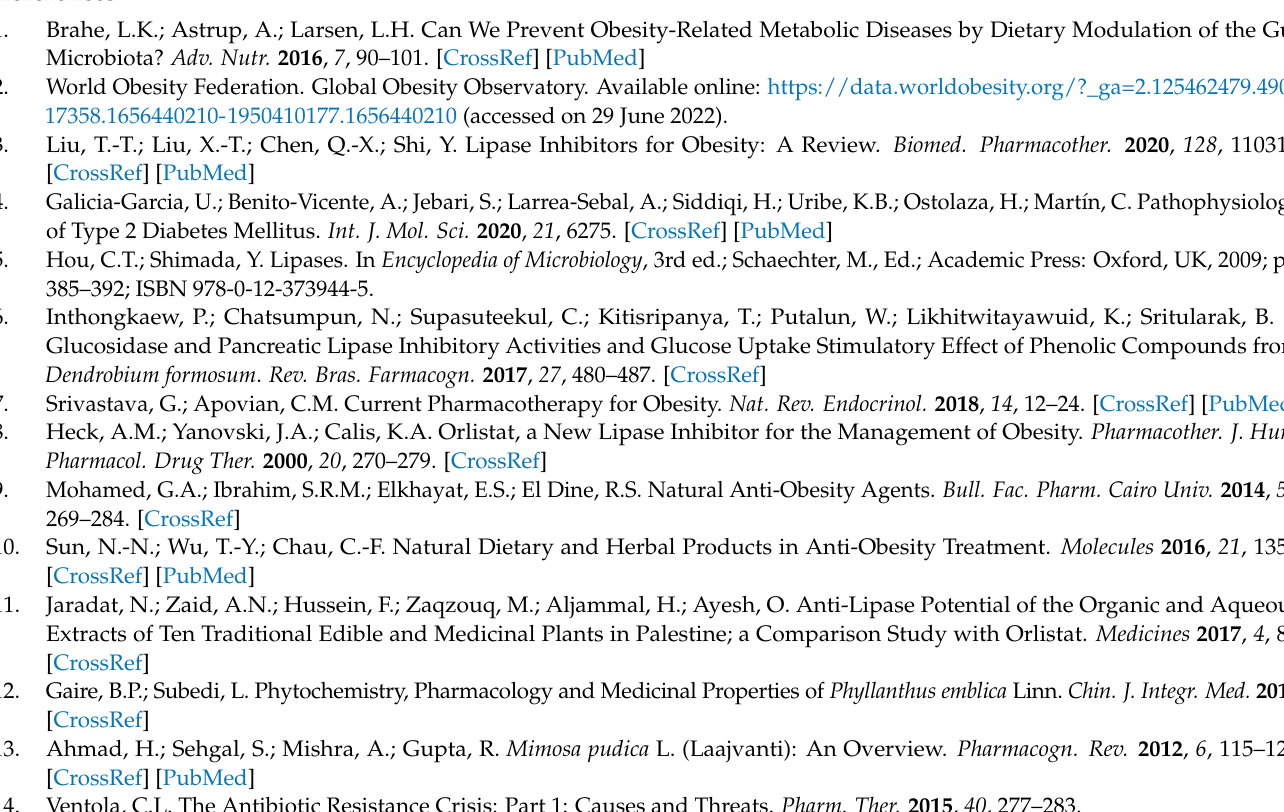
blica against E. coli ; Figure S2: Mass spectrum of Bergenia ciliata ; Figure S3: Mass spectrum of Mimosa pudica ; Figure S4: Mass spectrum of Phyllanthus emblica ; Figure S5: Fragmentation pattern of bergenin; Figure S6: Fragmentation pattern of diosmetin; Figure S7: Fragmentation pattern of trihydroxy-dimethoxyflavone; Figure S8: Fragmentation pattern of catechin/epicatechin; Figure S9: Fragmentation pattern of gallocatechin/epigallocatechin; Figure S10: Fragmentation pattern of chloro- genic acid; Figure S11: Fragmentation pattern of myricetin; Figure S12: Fragmentation pattern of isoquercetin; Figure S13: Fragmentation pattern of prodelphinidin B3; Figure S14: Fragmentation pattern of kaempferol; Figure S15: Fragmentation pattern of emodin; Figure S16: Fragmentation pattern of isorhamnetin; Figure S17: Fragmentation pattern of methyl